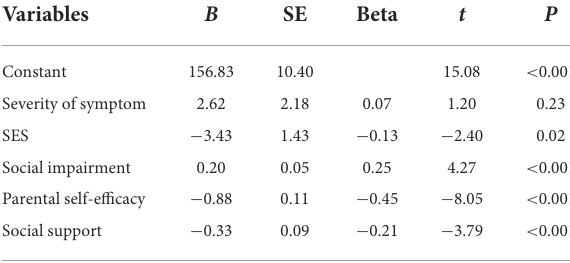
TABLE 4 Predictors of parenting stress in mothers of children with